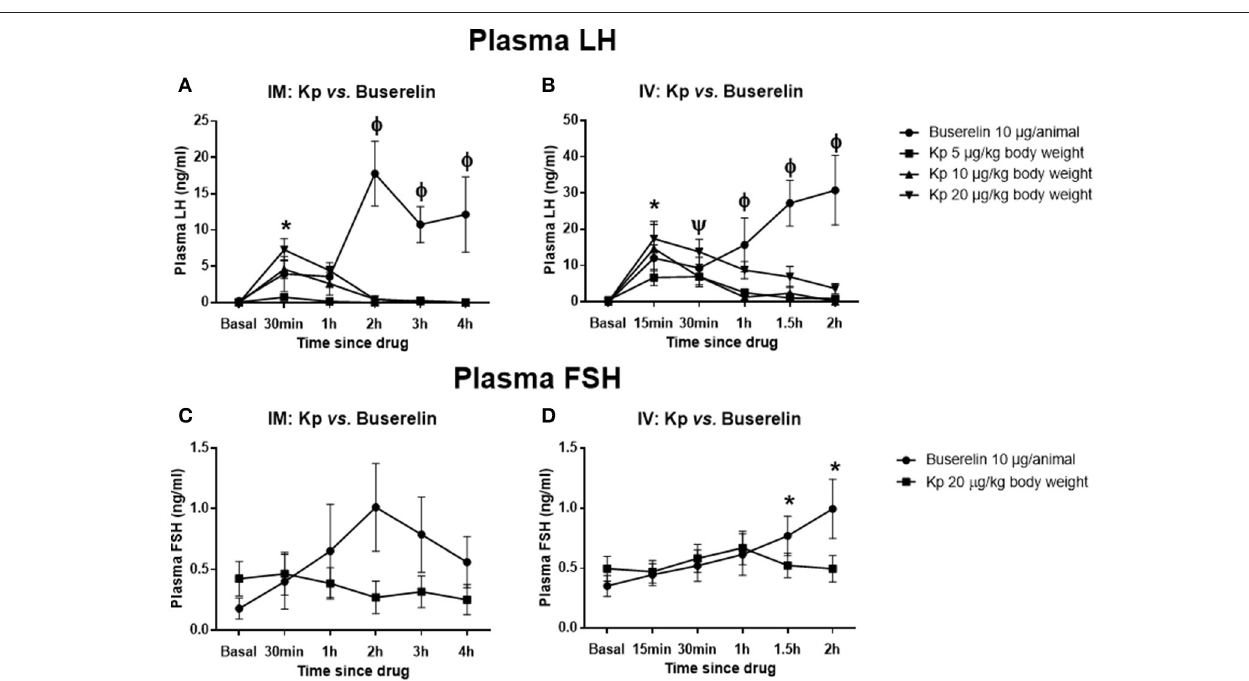
FIGURE 3 | Effect of kisspeptin or buserelin on plasma LH and FSH levels in pre-pubertal buffaloes out of the breeding season. (A) Kisspeptin IM dose-dependently elevated plasma LH levels in pre-pubertal buffaloes. However, the LH level reached basal values by 2h. Buserelin resulted in a gradual but sustained increase in LH level (*kisspeptin 20 µ g/kg: basal vs. at 30min; kisspeptin: 5 vs. 20 µ g/kg at 30min; φ buserelin: basal vs. at 2, 3, and 4h; buserelin vs. all kisspeptin groups at 2, 3, and 4h time points; P < 0.05, RM ANOVA followed by Dunnett’s multiple comparison test). (B) The release kinetics of LH upon IV injections of the drugs were similar to that of IM injections of drugs. (*buserelin: basal vs. at 15min; kisspeptin: basal vs. kisspeptin 10 and 20 µ g/kg at 15min; 9 kisspeptin 20 µ g/kg: basal vs. at 30min; φ buserelin: basal vs. at 1, 1.5, and 2h; buserelin vs. kisspeptin 5 and 10 µ g/kg at 1h; buserelin vs. kisspeptin 5, 10, and 20 µ g/kg at 1.5 and 2h; P < 0.05, RM ANOVA followed by Dunnett’s multiple comparison test). (C) There was no significant increase in plasma FSH upon IM injections of both drugs. (D) Buserelin significantly elevated plasma FSH at 1.5 and 2h post-injection, however, it was not significantly different from kisspeptin group (*buserelin: basal vs. at 1.5 and 2h; P < 0.05, RM ANOVA followed by Dunnett’s multiple comparison test). Data represented as mean ± SEM ( n = 5–6 animals at each time